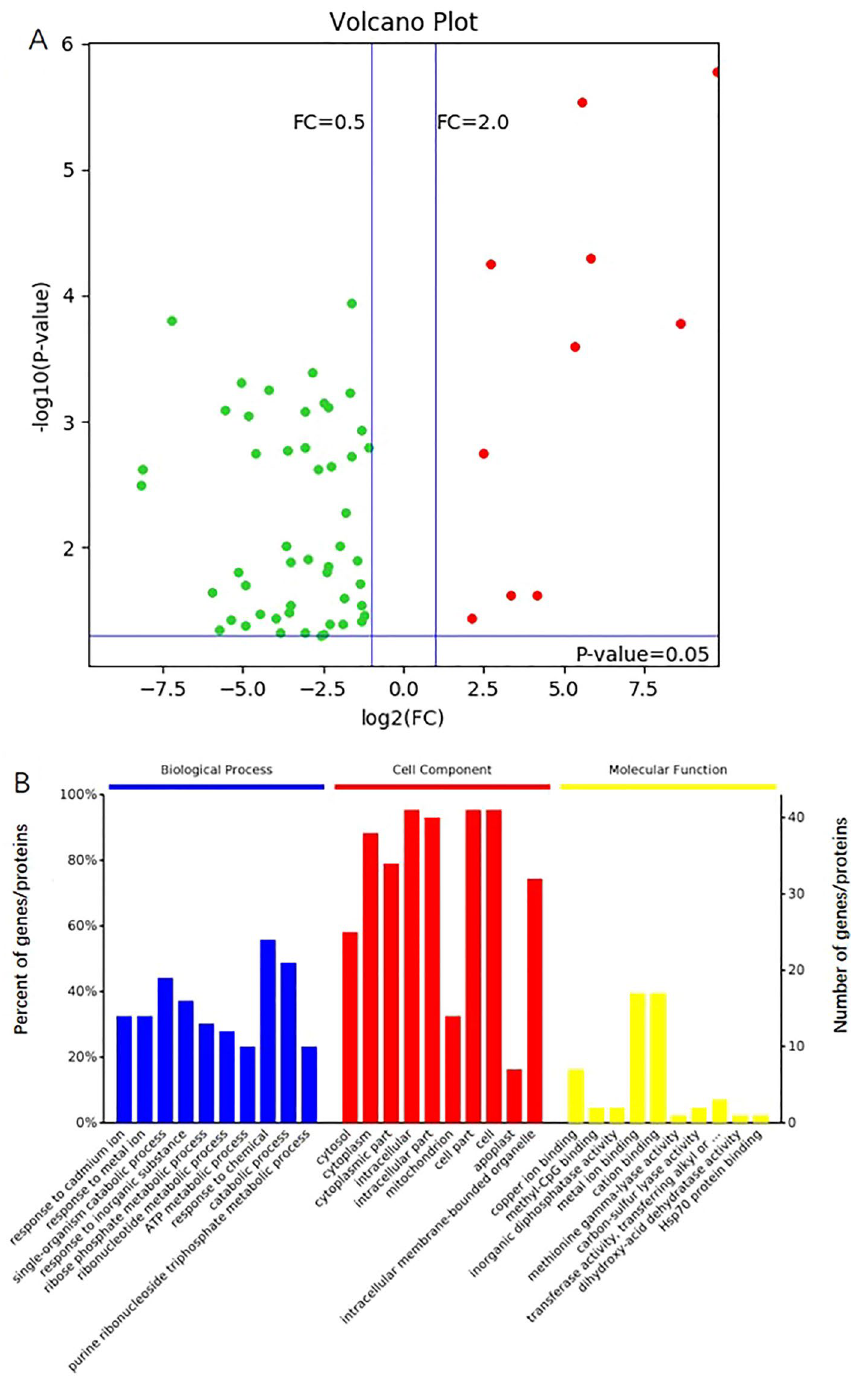
Figure 6. Volcano plot of DEPs ( A ) and GO term classification ( B ). A, Red plots indicate upregulation, and green plots indicate